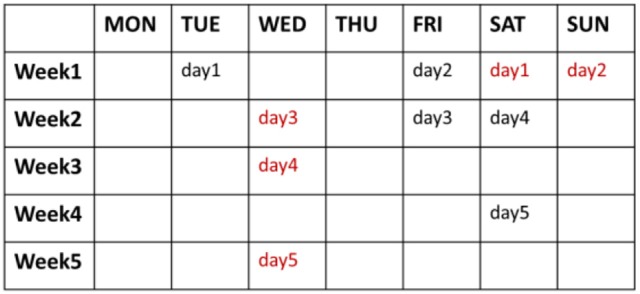
Data collection days for two representative subjects.